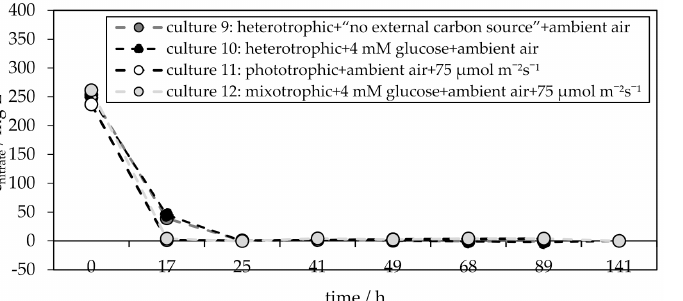
Figure 15. Time course of the nitrate concentration in the supernatant of the culture 9 (heterotrophic + “no external carbon source” + ambient air) and culture 10 (heterotrophic + 4 mM glucose + ambient air), phototrophic culture 11 (phototrophic + ambient air + 75 µ mol m − 2 s − 1 ) and mixotrophic